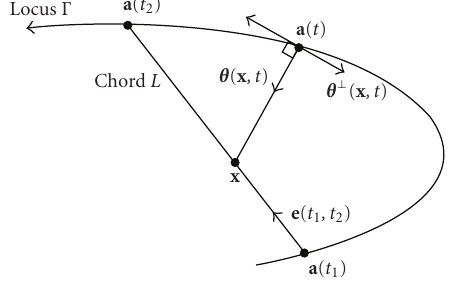
Figure 1: Global coordinate system and variables for fan-beam lambda